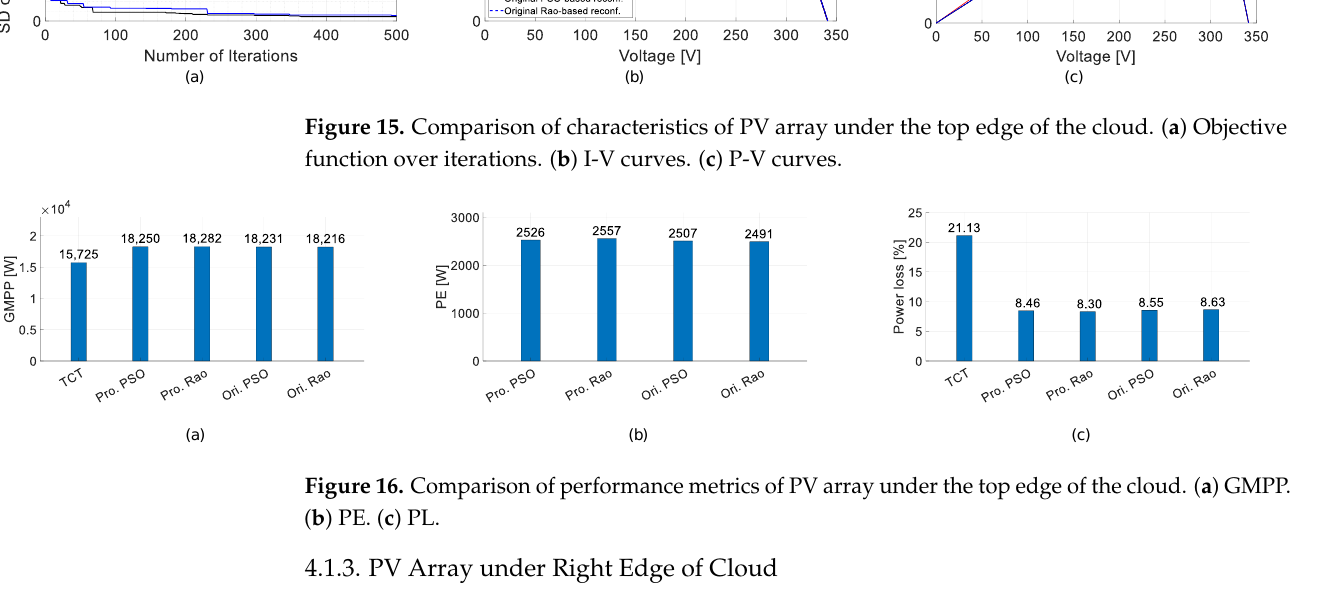
Under the right edge of the cloud, the difference in the total irradiance on the rows of the PV array before and after the reconfiguration is not significant as the PV array under the center and the top edge of the cloud. This is because the low-irradiance areas under the right edge of the cloud are already located in a row-wise manner on the PV array (Figure 17). The proposed-PSO-reconfigured and proposed-Rao-reconfigured PV arrays give the lowest SDI (Figure 18a), the smoothest I-V curves (Figure 18b), and the highest peaks on the P-V curves (Figure 18c). The GMPP, the PE, and the PL of the proposed reconfigured PV arrays are better than those of the TCT and original reconfigured PV arrays (Figure 19). It can be seen in Figure 19c that the right edge of the cloud does not much affect the output power of the PV array as the center and top edge of the cloud